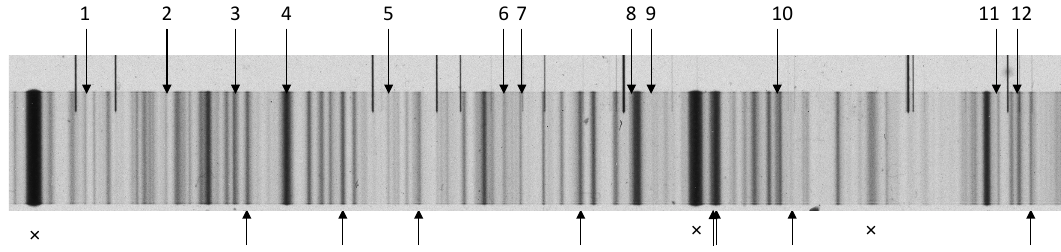
Figure 1. Section of a vacuum triggered spark spectrum (2863–2875 Å). Downward arrows: the U II lines identified in the present work, their numbers and corresponding wavelengths can be found in Table 9; Upward arrows: U III lines from [12]; x: Unidentified lines, likely from U IV. The superimposed iron spectrum is visible above the uranium spectrum but not used in the present work.